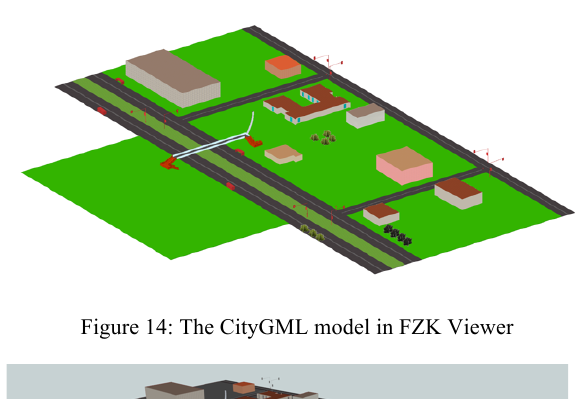
Figure 13: Modeling in Trimble SketchUp